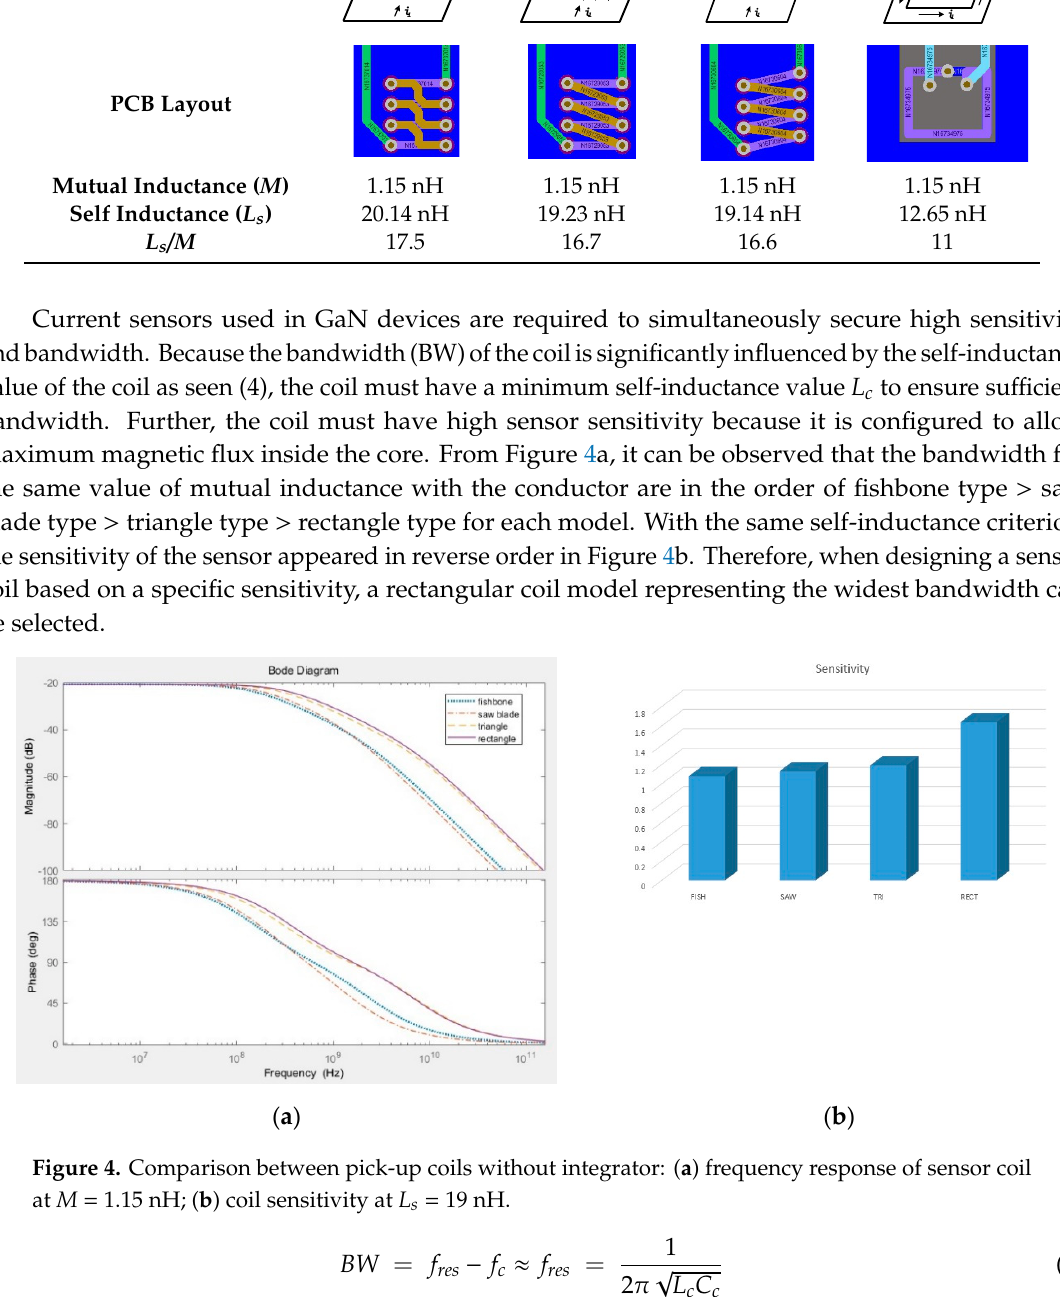
Figure 4. Comparison between pick-up coils without integrator: ( a ) frequency response of sensor coil at M = 1.15 nH; ( b ) coil sensitivity at L s = 19 nH.